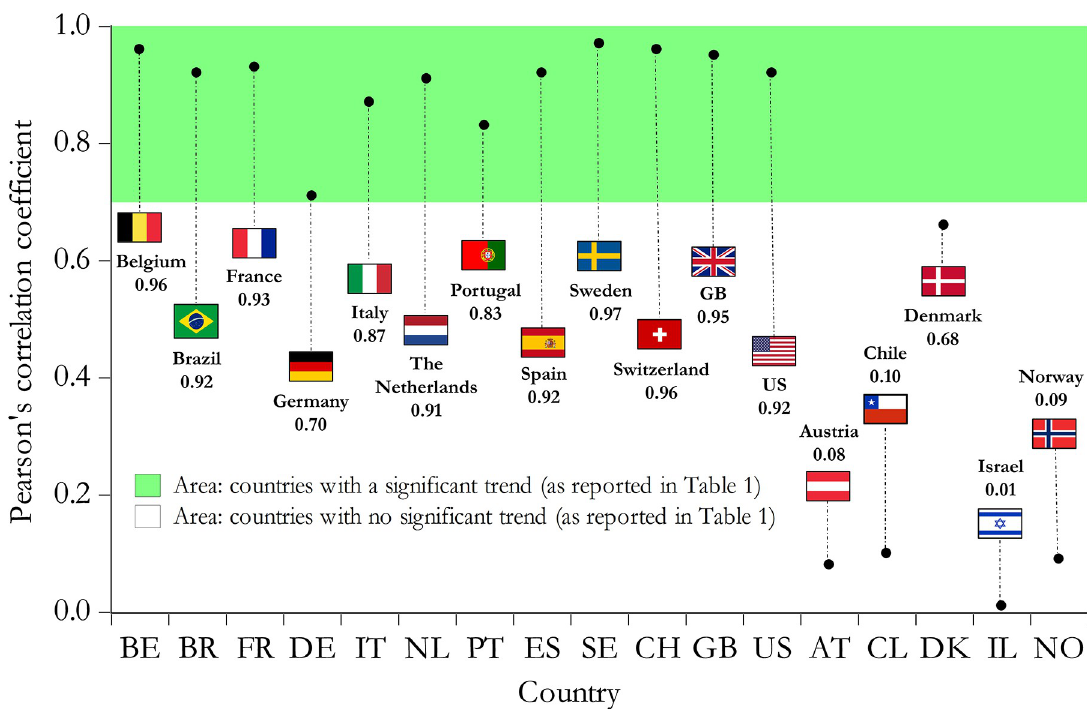
Fig 6. Correlation coefficient between COVID-19 deaths and excess